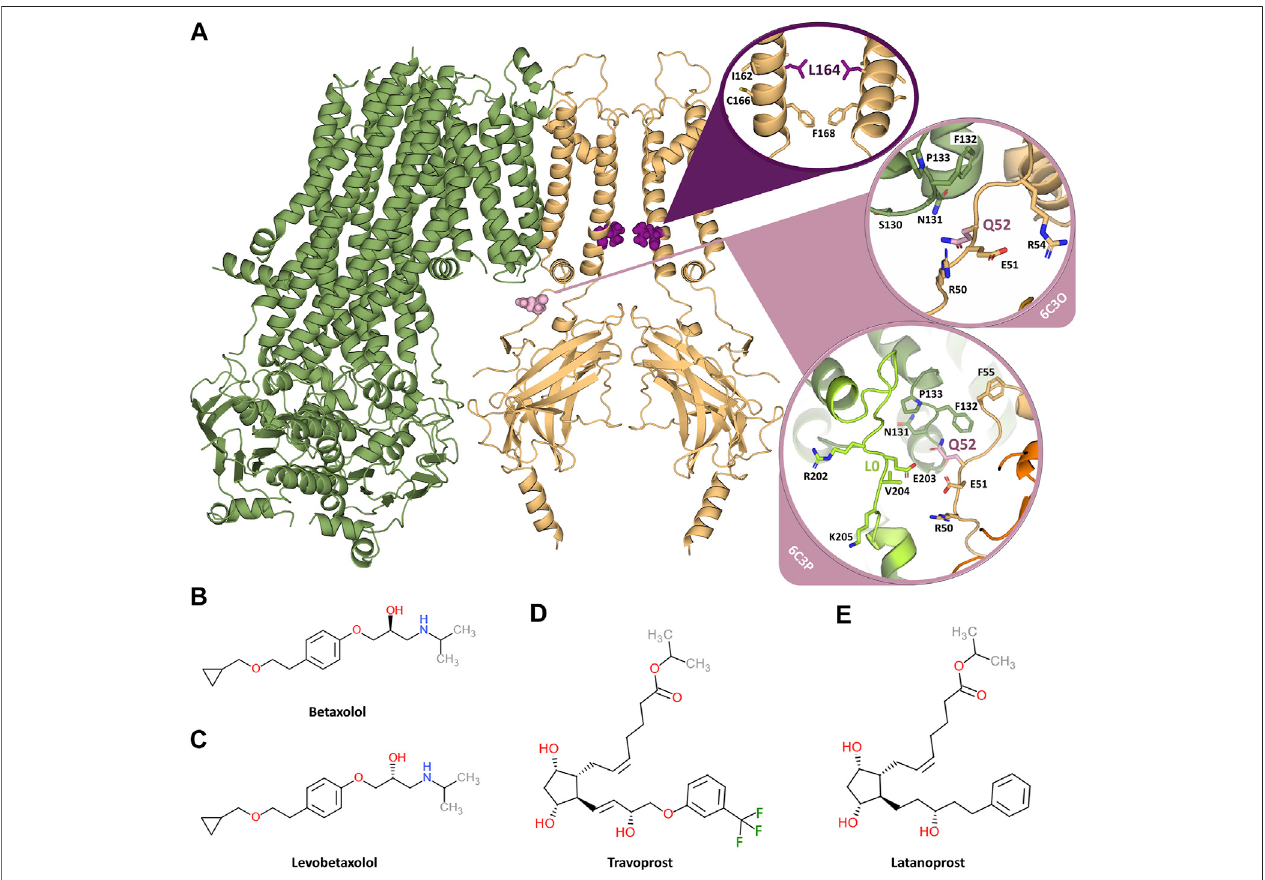
FIGURE 1 | Overview of the K ATP channel and the investigated inhibiting compounds. (A) Two opposing subunits of the K IR 6.2 channel pore are shown in orange, one SUR1 subunit is shown in green. The two mutation sites L164 and Q52 are shown in purple and pink, respectively. The circles provide close-ups of the mutation sites. Since Q52islocatedonthesurfaceofK IR 6.2closetoSUR1andtheorientation oftheSUR1subunitsisdifferentinthe6C3O and 6C3Pstructure,theclose-upsof Q52areshownforbothstructures.TheloopL0,whichcomprisesresiduesimportantforK IR -SURcoupling,isshowninlightgreenforthe6C3Pstructure,whileitis not modelled in the 6C3O structure. (B) Chemical structure of betaxolol. (C) Chemical structure of levobetaxolol. (D) Chemical structure of travoprost. (E) Chemical structure of